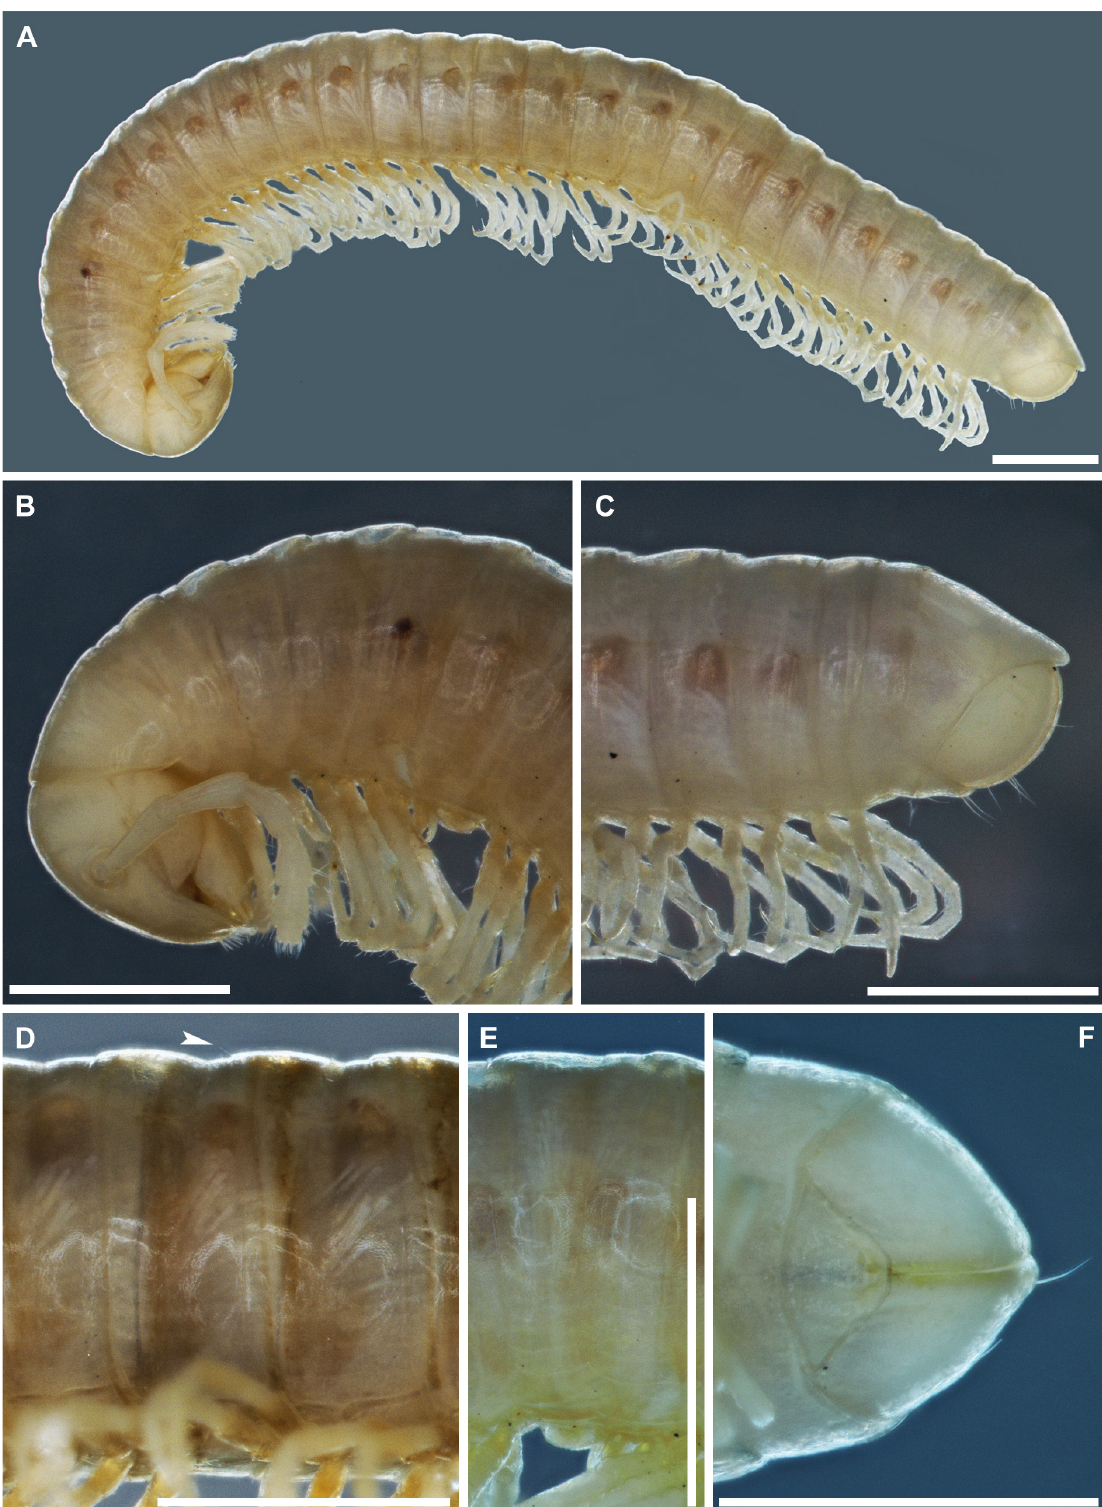
Fig. 50. Martvilia parva gen. et sp. nov. (A–C, E: holotype ♂ from Jortsku Cave (ZMUM); D, F: non-type ♀ from Motena Cave (IZB)). A . Habitus, lateral view. B . Anterior part of body, lateral view. C . Posterior part of body, lateral view. D . Midbody rings, lateral view. E . Body ring 7, lateral view. F . Telson, posterior view. Arrow indicates metazonal seta. Scale bars: 1